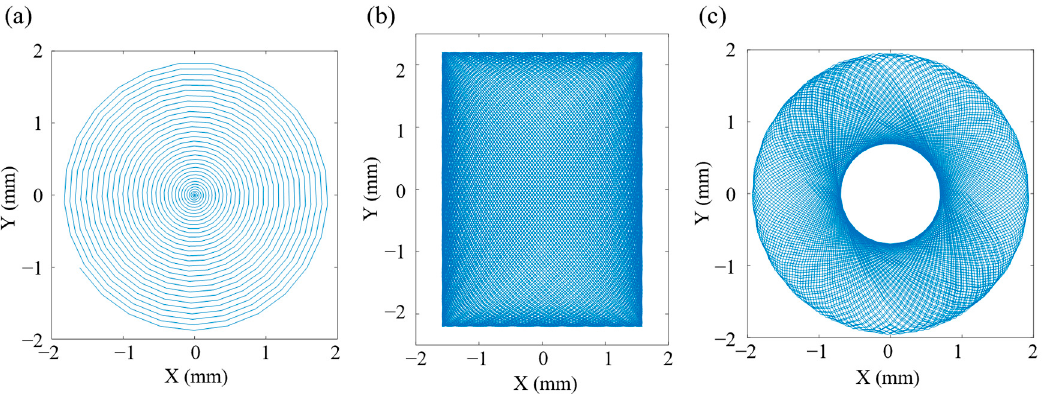
Figure 7. Transient analysis results of scanner: ( a ) spiral scanning pattern; ( b ) Lissajous scanning pattern; ( c ) propeller scanning pattern.